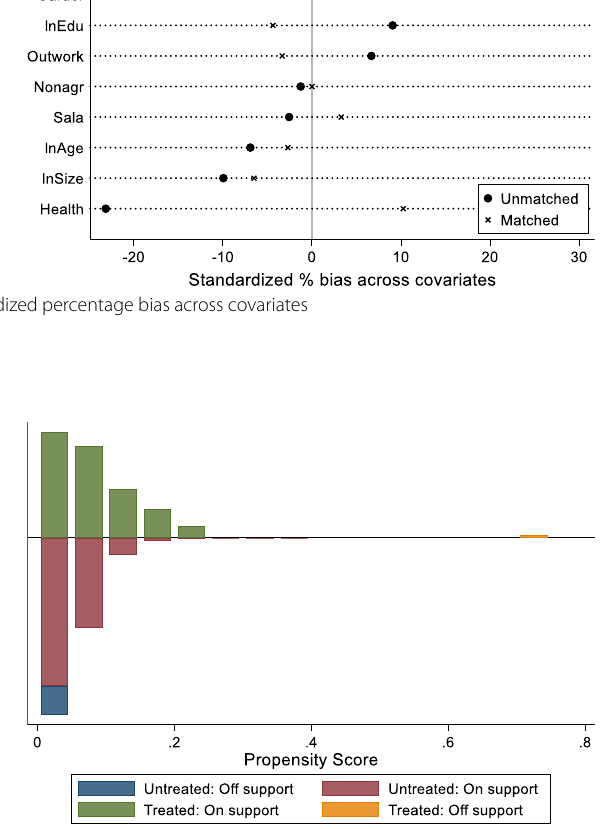
Fig. 2 PSM common support